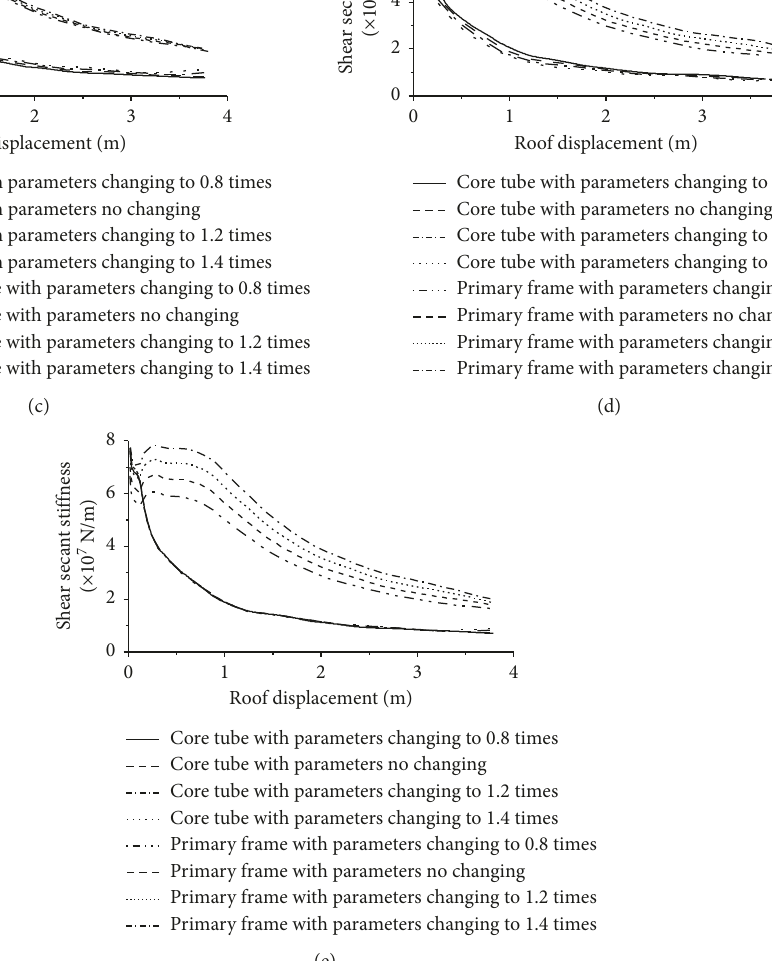
Figure 21: Influence of key parameters on shear secant stiffness degradation of primary frame in model 5MBC: (a) thickness of shear walls, (b) height of coupling beams, (c) height of primary beams, (d) sectional area of primary columns, (e) sectional area of